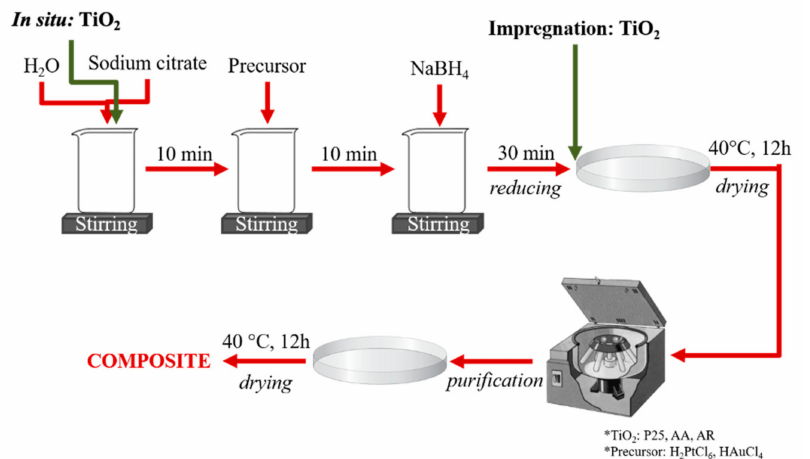
Figure 1. Synthesis and purification of the nanocomposites by the chemical reduction of Au and Pt, using in situ and impregnation as possible pathways of the